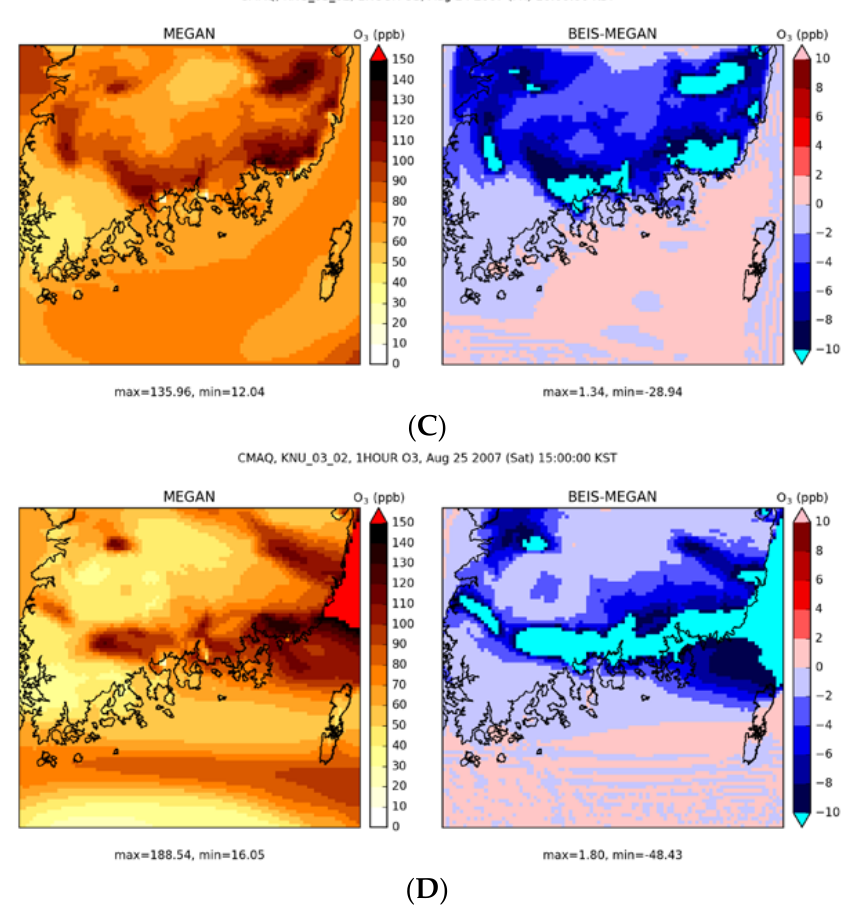
Figure 9. One-hour ozone concentrations estimated with CMAQ-MEGAN ( left ) and differences between CMAQ-MEGAN and CMAQ-BEIS3 ( right ) in 2007: ( A ) 5 PM on 17 August; ( B ) 3 PM on 18 August; ( C ) 4 PM on 24 August; and ( D ) 3 PM on 25 August.